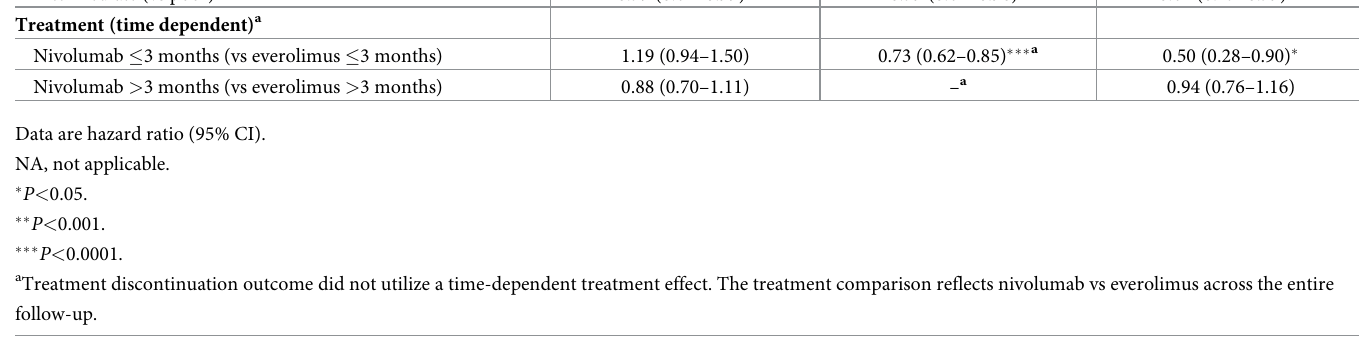
Based on AIC/BIC measures, log-cumulative hazard plots, parametric plots, and visual inspec- tion, none of the parametric distributions provided a better fit to the observed trial data. Hence, Weibull distributions were selected to model TTD, TTP, and TTDeath because they provide a good benchmark for comparison as they have recently been used in oncology model- ing, especially with immuno-oncology therapies [33–35]. The parameters associated with TTD, TTP, and TTDeath are listed in S1 Table.